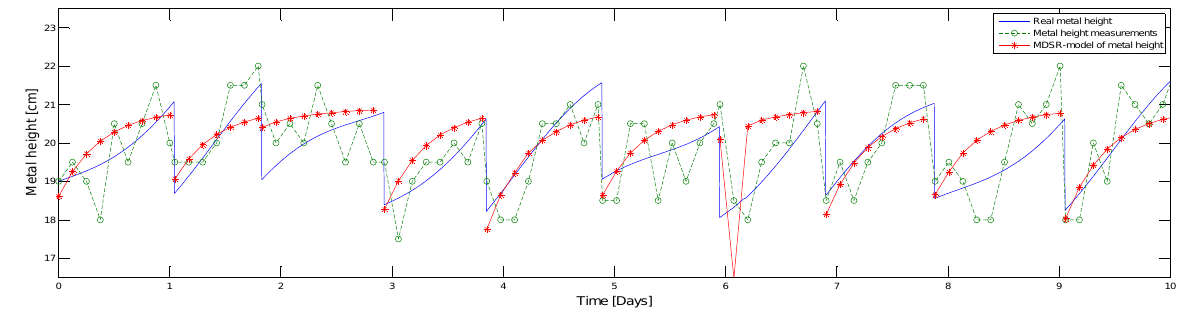
Figure 10: Prediction of the metal height, using MDSR on the earlier synthetic data set. Unlike the assumed measurement regime for the OLS and ROLS models, the metal height is here assumed to be measured every 3rd hour, but as opposed to the measurement regime using the DSR, here the measurements are considered as multiple time series, each starting just after the tapping proceeding. The noisy metal height measurements are shown with the green circles in the figure. In general, the simulated values are closer to the predicted than the measured values.